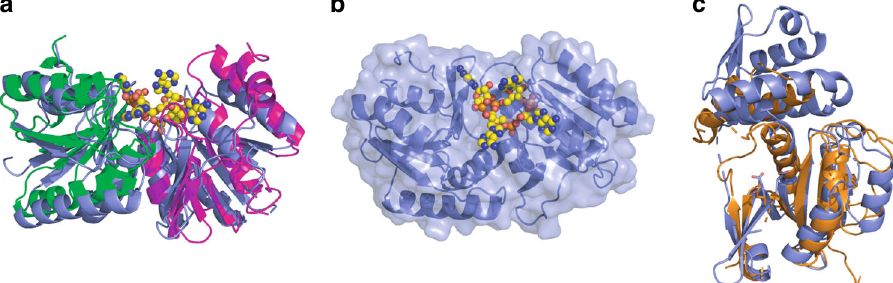
Fig. 3 Structural comparison of Can1 and the DUF1887 family protein VC1899. a Superimposition of the CARF domains from Can1 (coloured as in Fig. 1) in complex with cA 4 (yellow spheres) with the CARF domain from VC1899 (mauve). The VC1899 dimer (monomer plus the symmetry mate that forms the functional dimer) was overlapped with Can1. b Surface and cartoon representation of VC1899, with cA 4 (yellow spheres) modelled based on the superimposition shown in panel ( a ). c Superimposition of the nuclease domain from Can1 (orange) and the nuclease domain from VC1899 (mauve). The active site residues are shown as